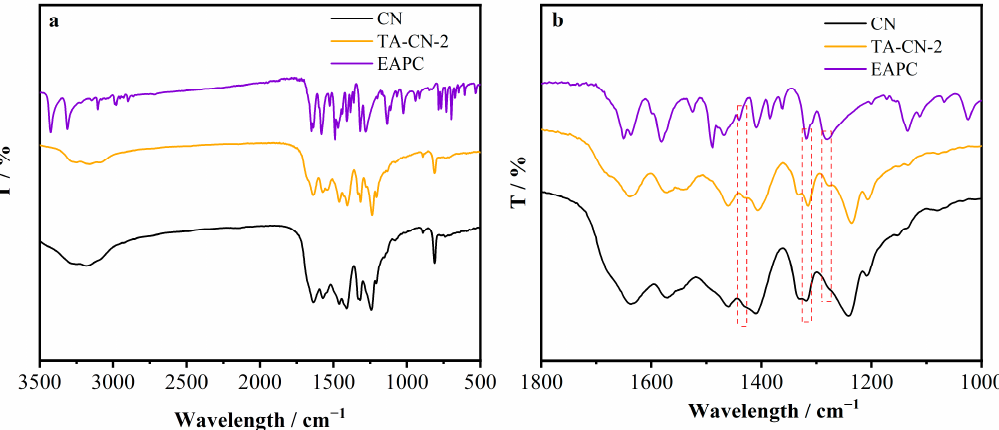
Figure 3. ( a ) FTIR spectra of CN, TA-CN-2 and EAPC, ( b ) enlarge view between 1800 and 1000 cm − 1 .